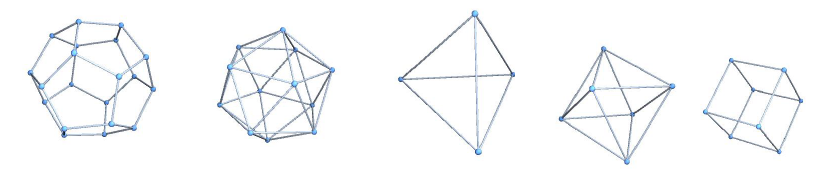
Figure 1. The spectral drawings of the skeletons of Platonic solids.